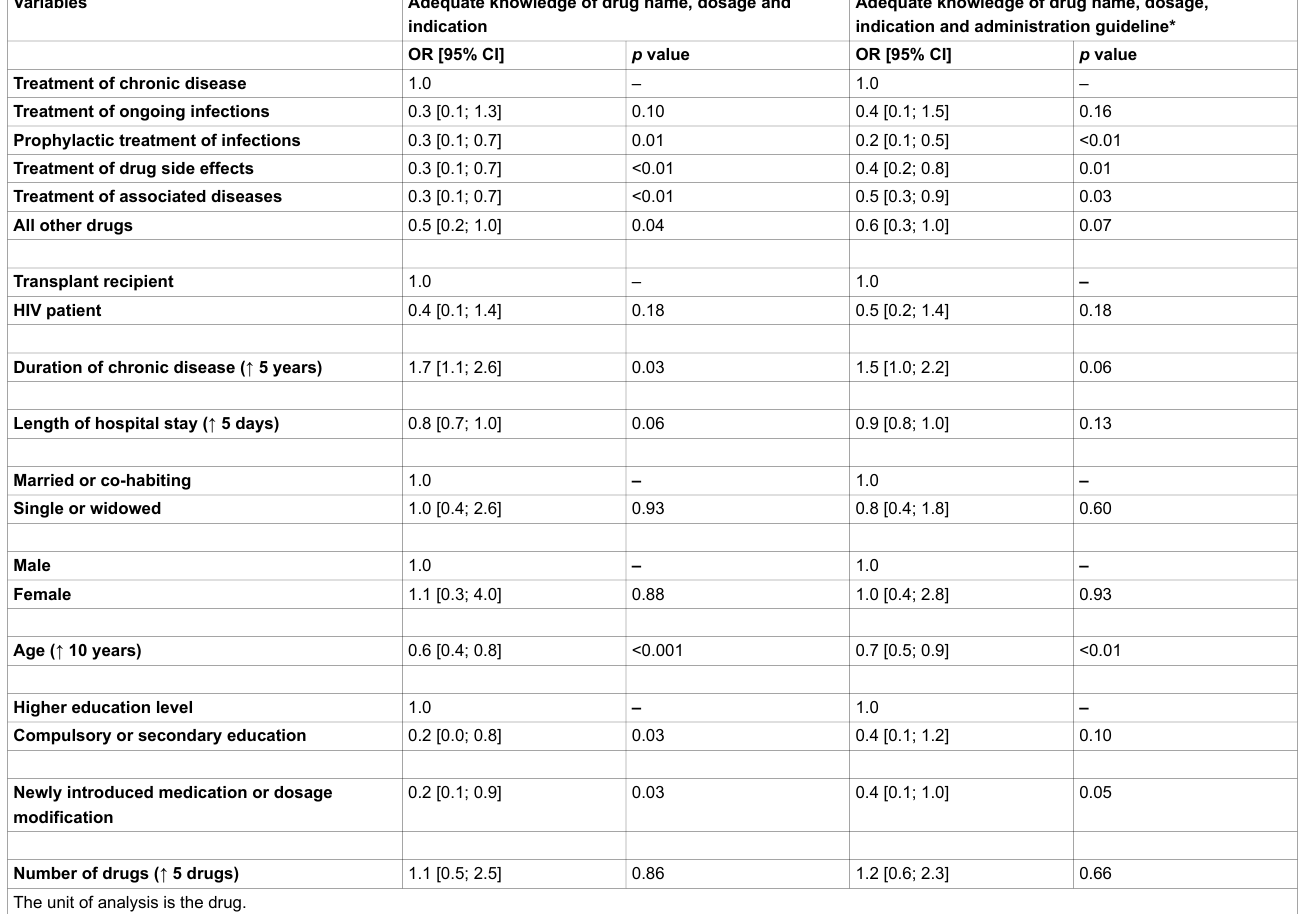
Table 3: Association between patients and drug characteristics and adequate knowledge of 497 drugs taken by 55 patients on discharge.